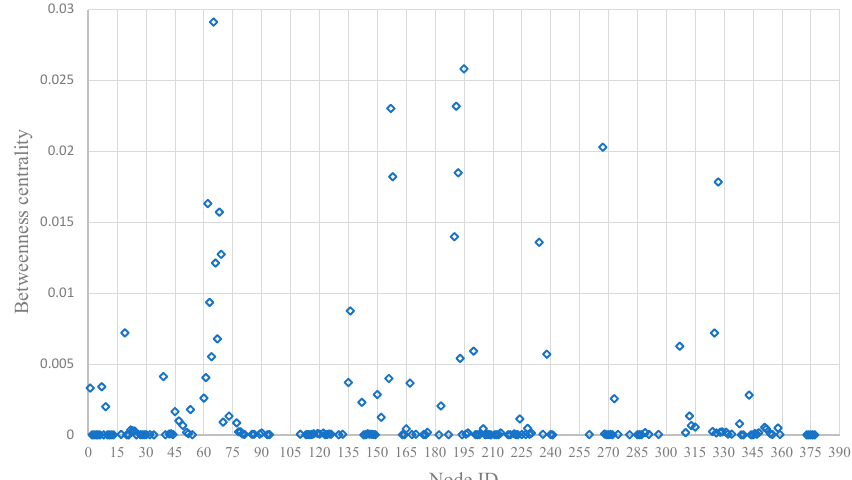
Figure 8. Betweenness centrality of nodes in the ENRRTP.